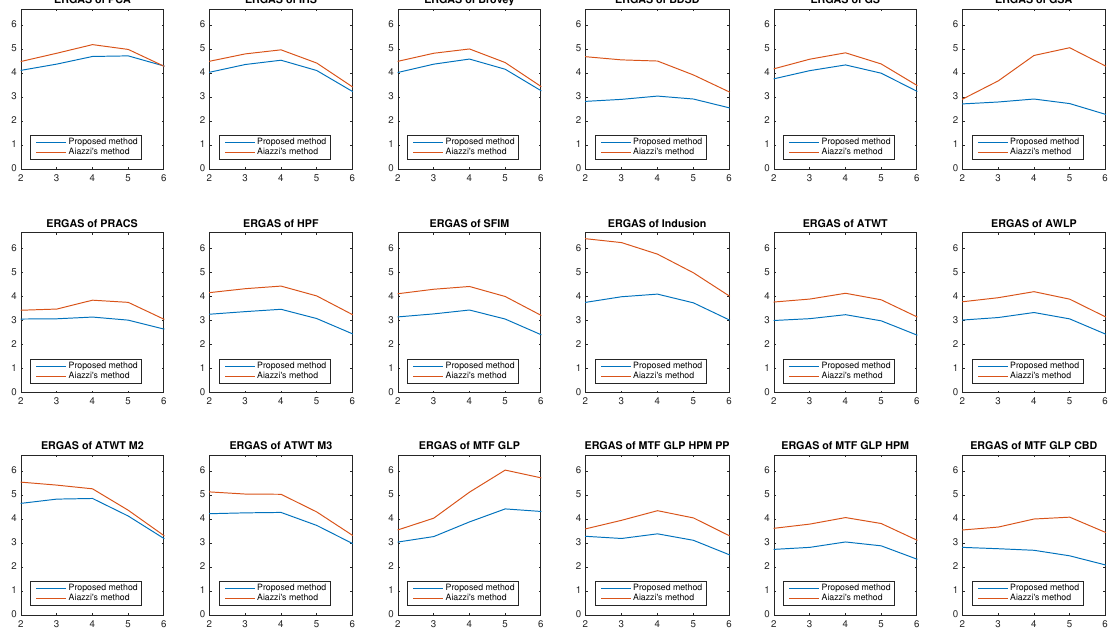
Figure 3. Relative dimensionless global error in synthesis (ERGAS) scores of fused image sequences constructed following Aiazzi’s method and